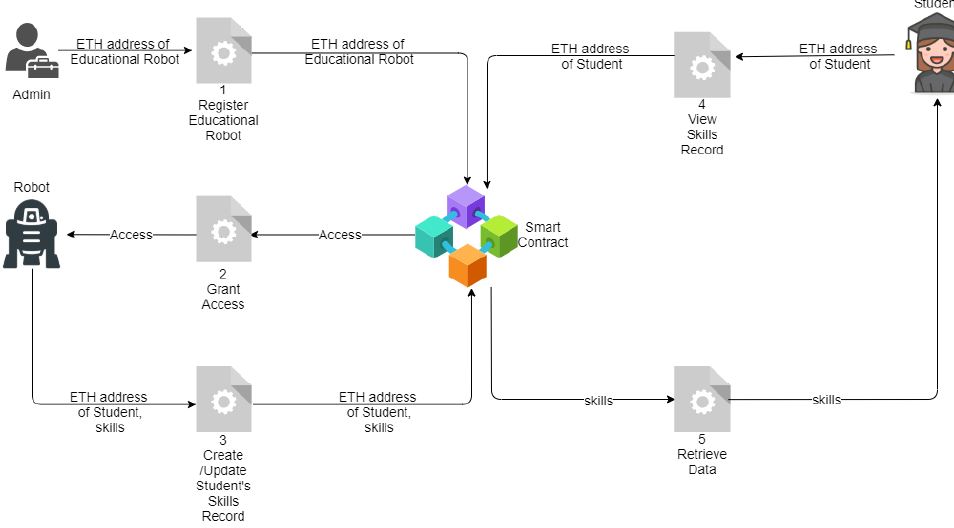
Figure 2. A schematic representation that presents the proposed